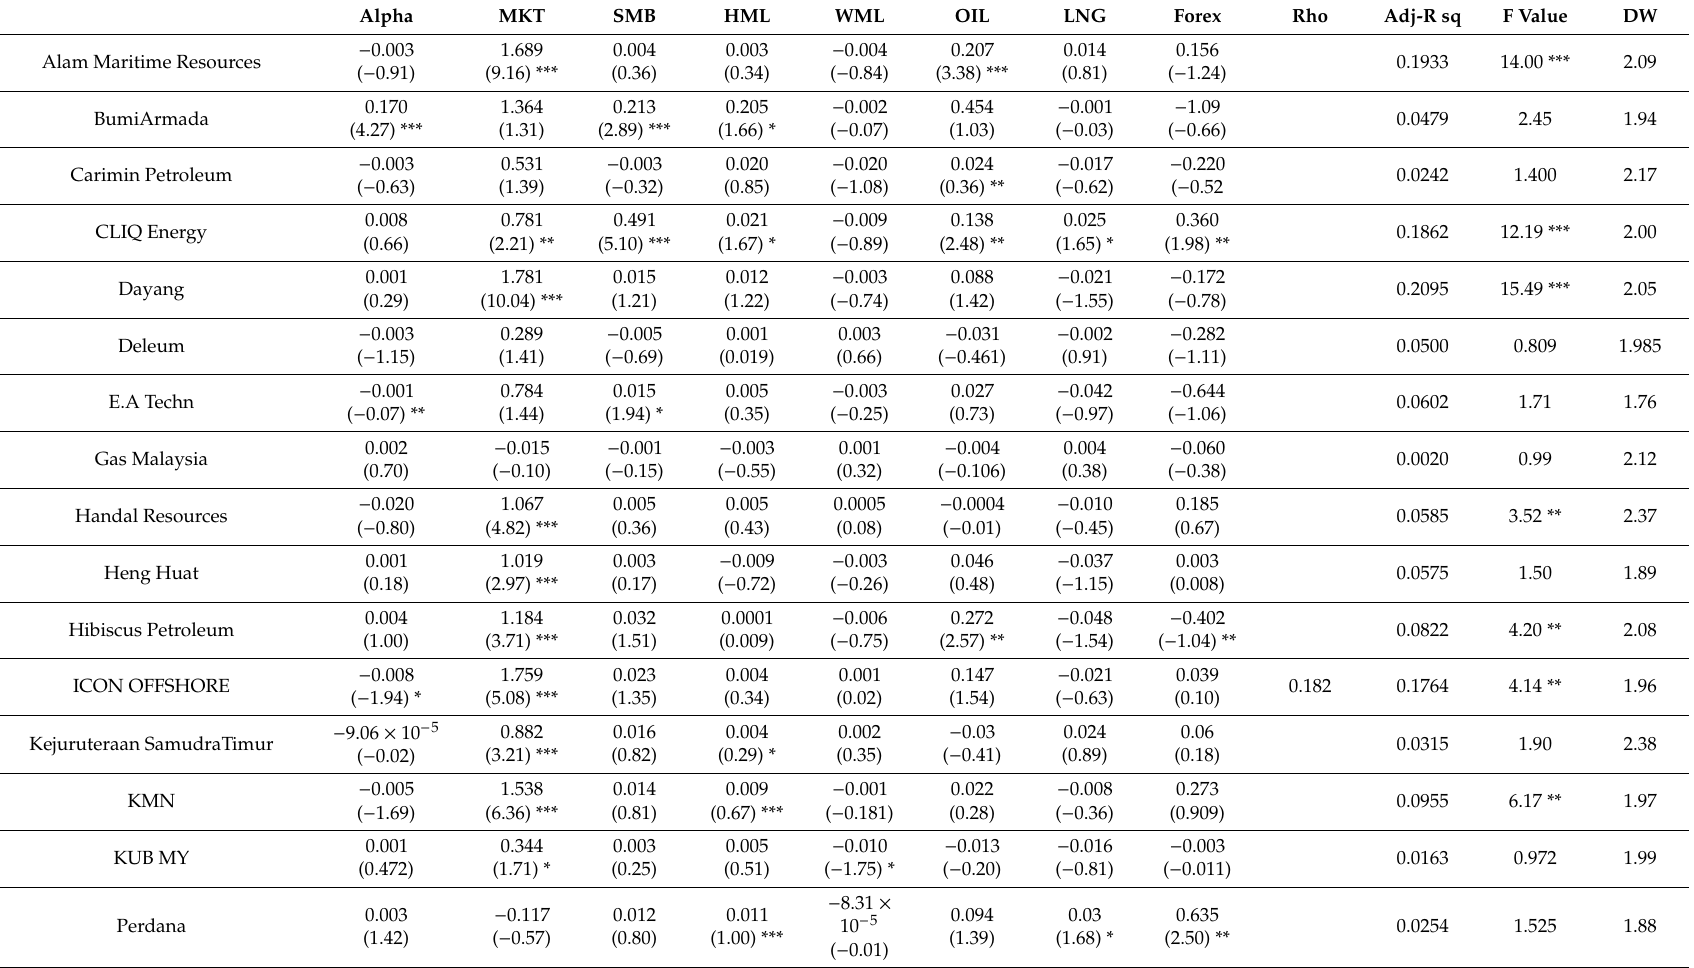
Table 5. Results of Time Series Regression under Mean-Variance Framework (Standard Risk